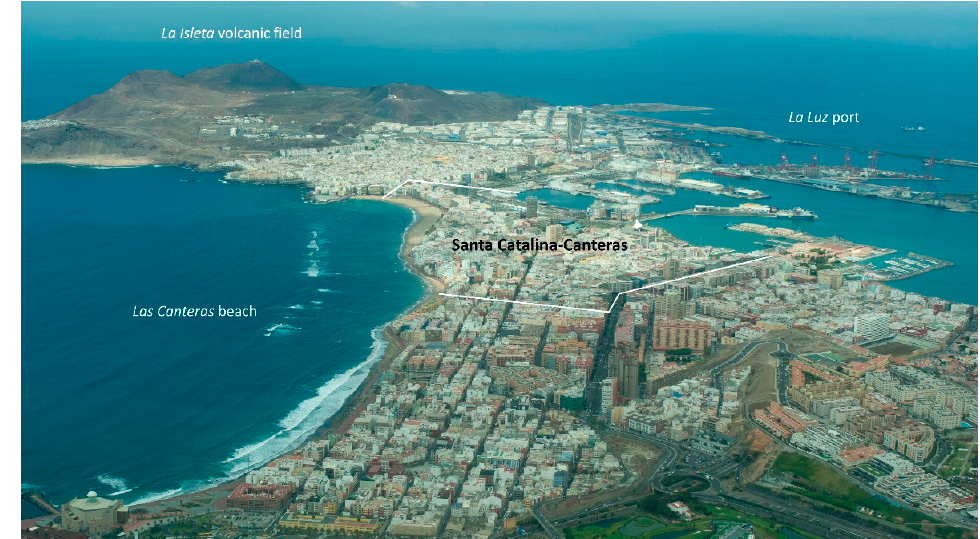
Figure 2. Aerial perspective of Santa Catalina-Canteras. Source: Own